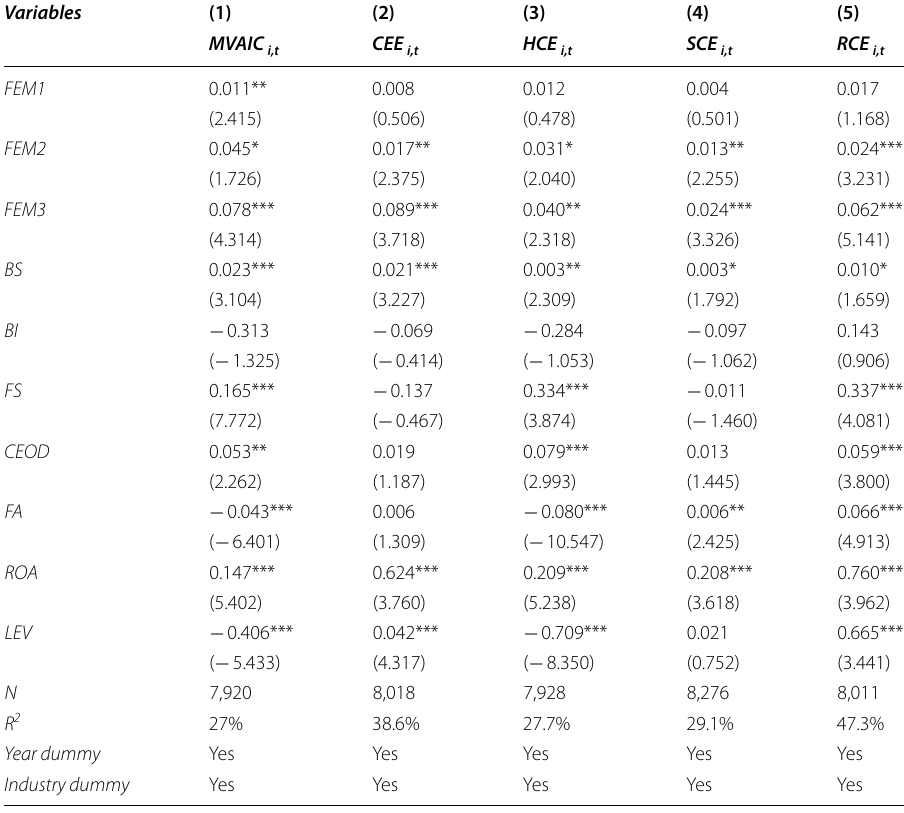
Table 5 Regression results for female director’s critical mass perspective